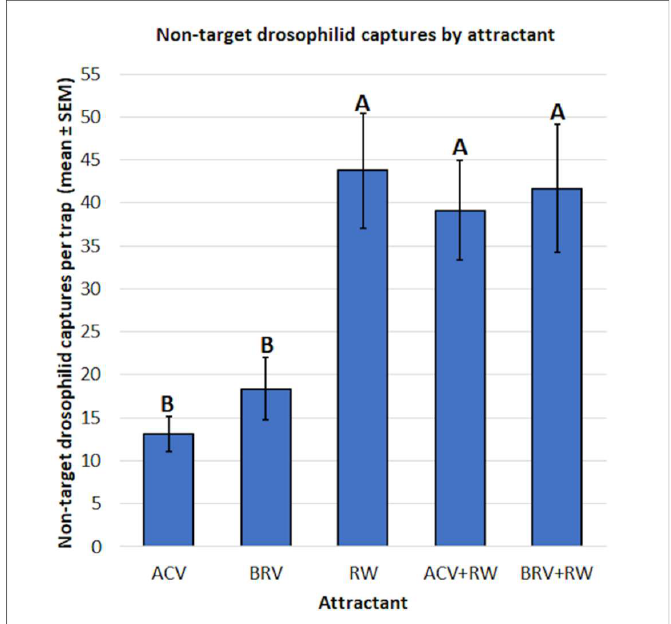
Figure 10. Mean (± SEM) non-target drosophilid captures by attractant. Different letters represent statistically significant differences ( p < 0.05, Tukey’s HSD test) between attractant solutions. There were significant differences observed in the mean captures by week surveyed (f = 37.25,